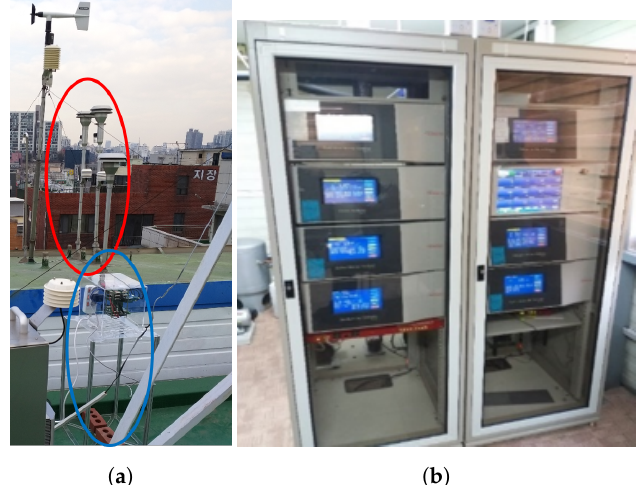
Figure 4. Information on governmental BAM station. ( a ) Outside; ( b ) Inside. It’s located at 6, Sadang-ro environment. Inlets of BAM (red circle) and Multi-sensor platform (blue circle) are located